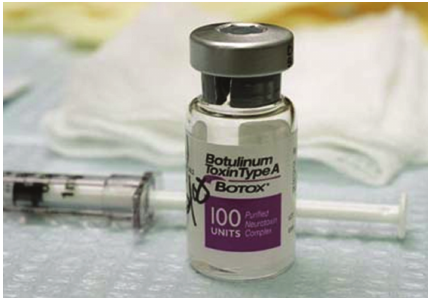
Figure 5: Botulinum